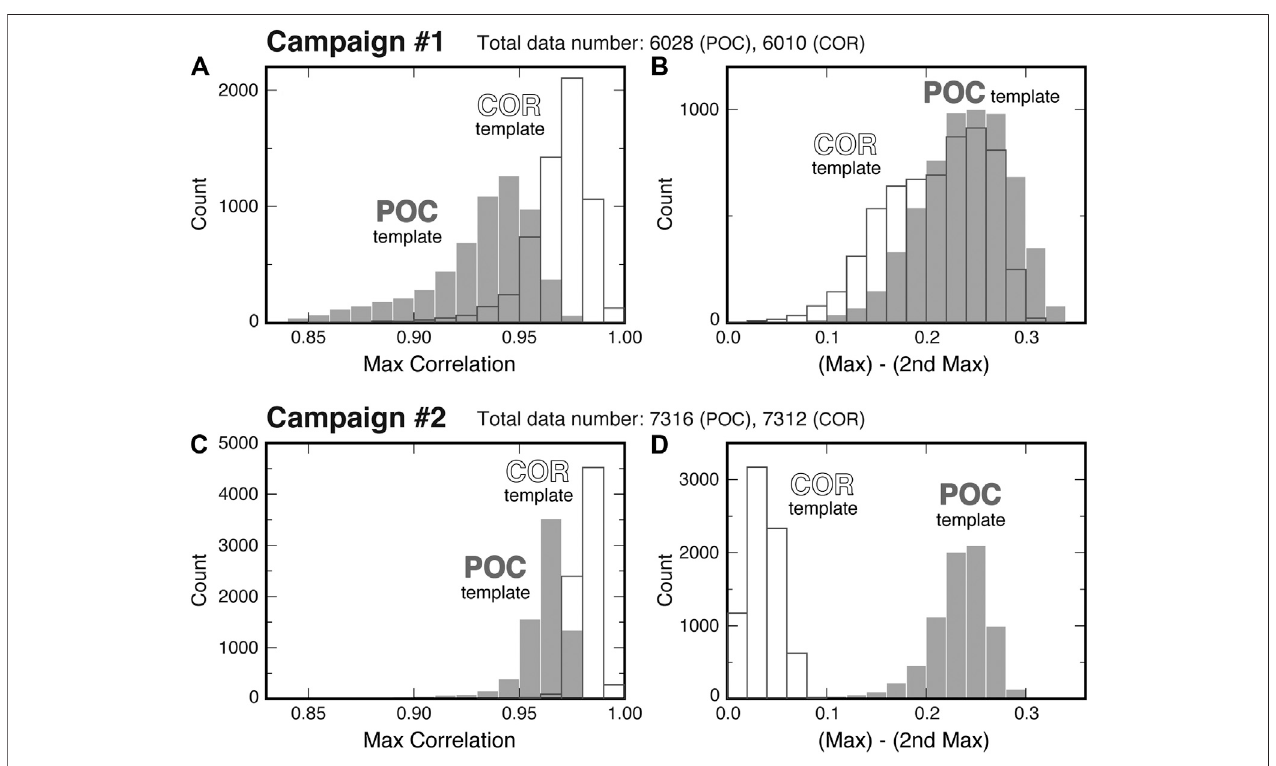
FIGURE6| Resultsoftemplatematchingforthetwocampaigns. (A) Histogramsofvaluesofthemaximumpeakofnormalized correlationobtainedusingthePOC template (gray bars) or the conventional cross-correlation template (white bars) for Campaign #1. (B) Histograms of differences between the maximum and second maximum peak values for Campaign #1. Bar colors mean the same as (A) . (C) and (D) show the same as (A) and (B) , respectively, but for Campaign #2.